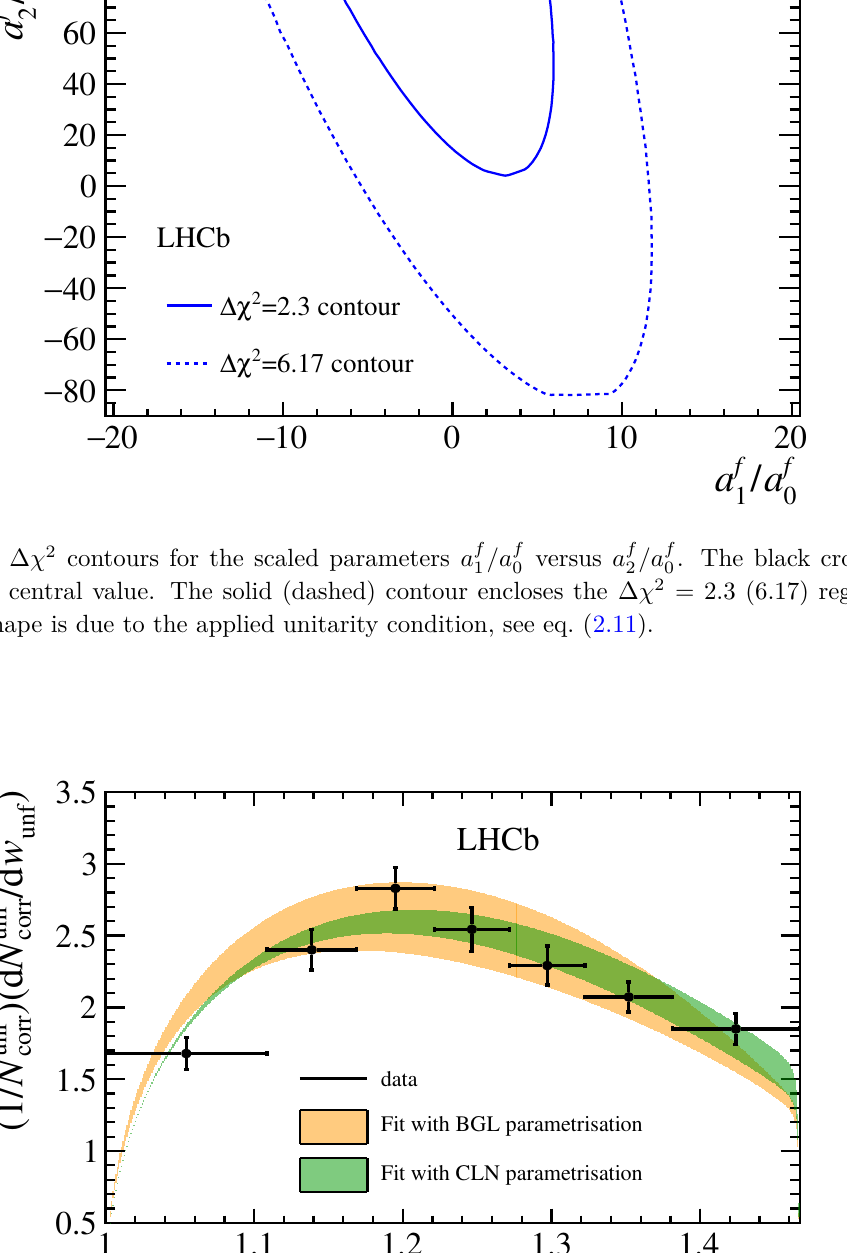
Figure 6 . Unfolded normalised differential decay rate with the fit superimposed for the CLN parametrisation (green), and BGL (red). The band in the fit results includes both the statistical and systematic uncertainty on the data